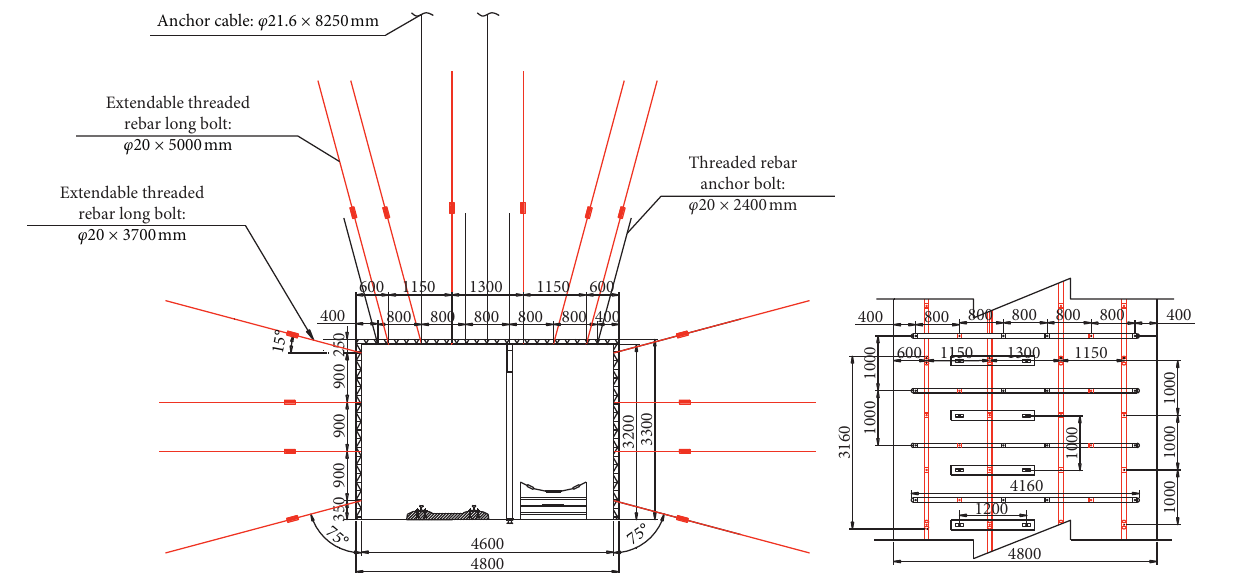
Figure 17: Support design for grade III roof in the intake airway of working face 11030.